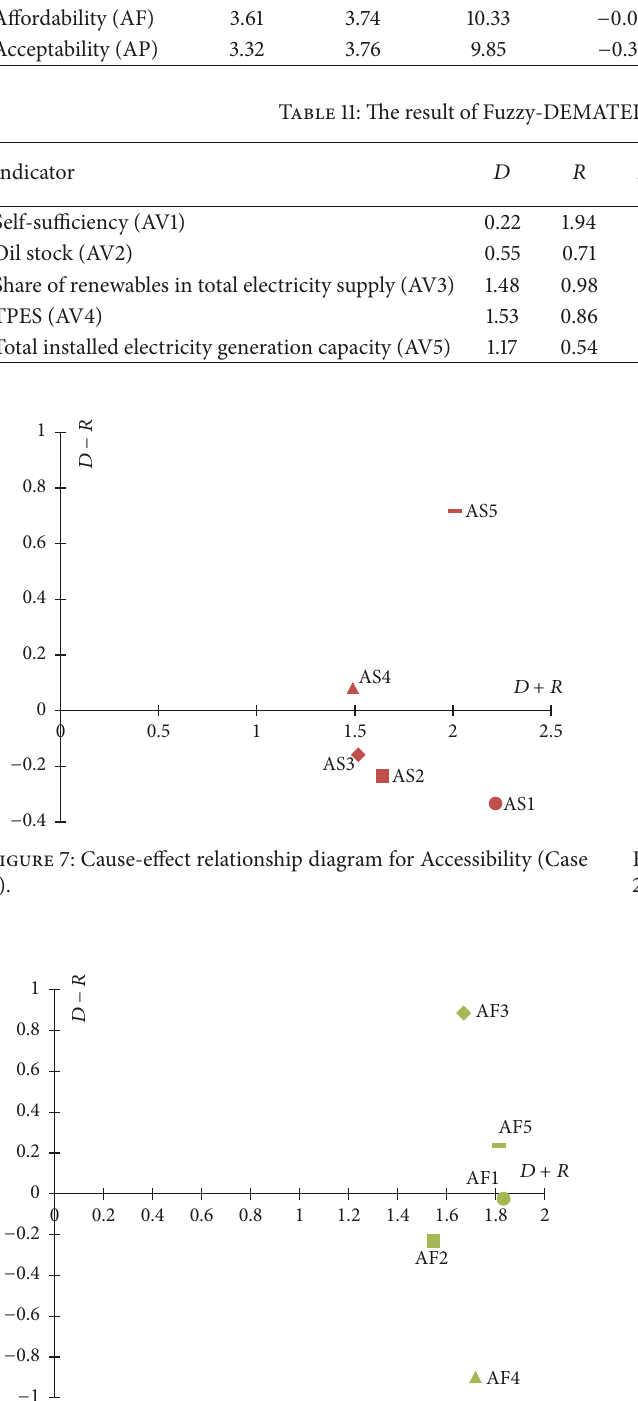
Figure 10: Cause-effect relationship diagram for all indicators of energy security (Case 3